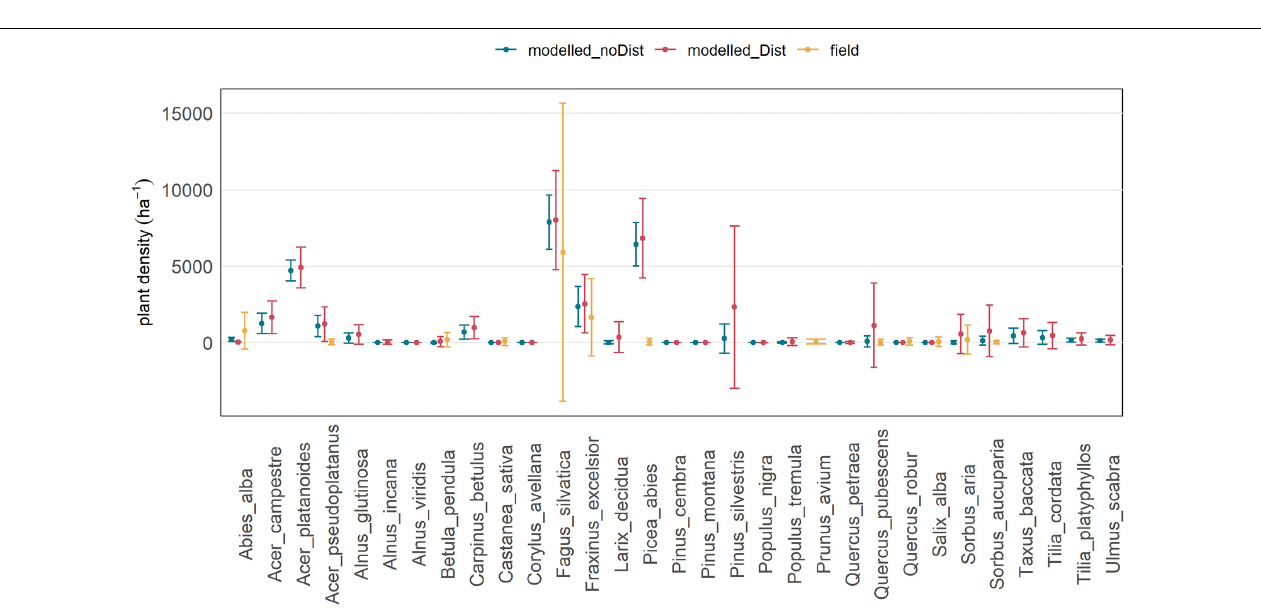
FIGURE 4 | Mean basal area and standard deviation of the species measured throughout the study area and/or modelled by TreeMig for the spin-up simulation with background disturbance (“modelled_Dist”; red), without background disturbance (“modelled_noDist”, blue), and based on field measurements in sample plots in recent and older intervention areas (“field”; orange) and sample plots in the rockfall zone (“field2”; green), where deciduous tree species with a low abundance were summarized as “deciduous”. The standard deviation represents the variation in the basal area between the sample plots (field data) and the cells (modelled data),